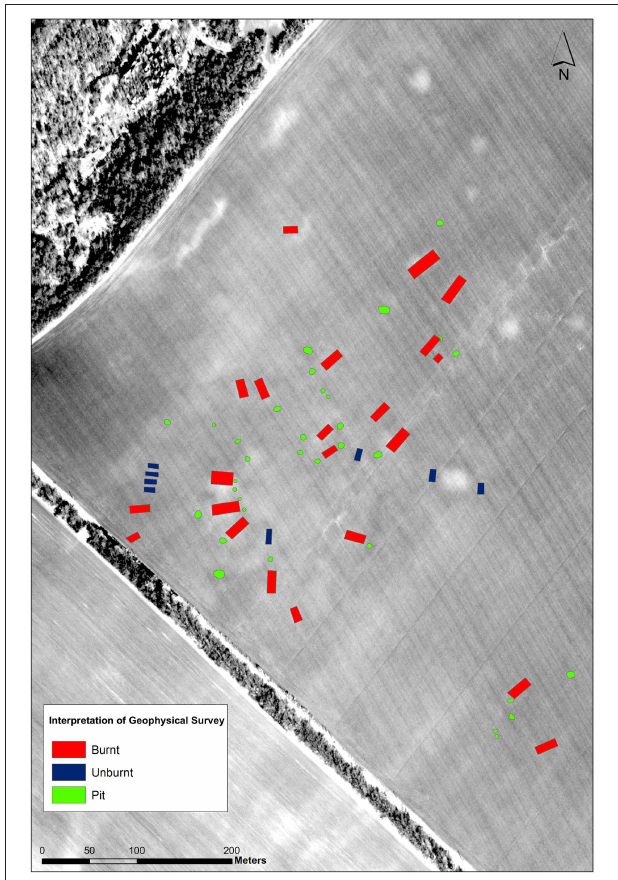
FIGURE 10 | Interpretative geophysical plan of the Trypillia Phase CI settlement of Apolianaka, showing geophysical anomalies interpreted as burnt and unburnt houses and pits (M. Nebbia, modified from Rassmann et al.,